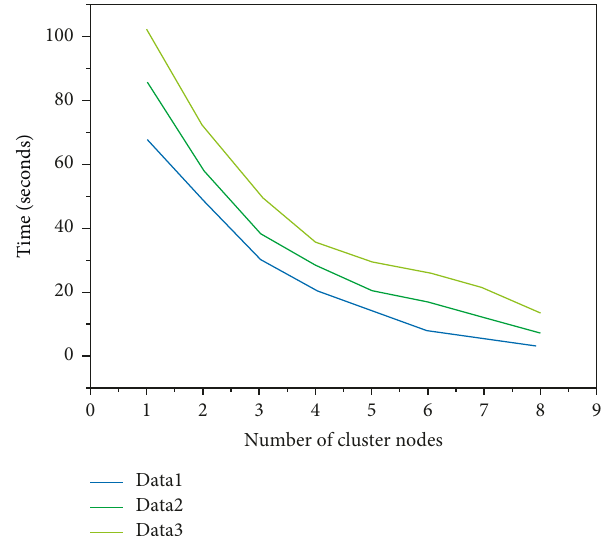
Figure 5: Performance test results of expansion rate.